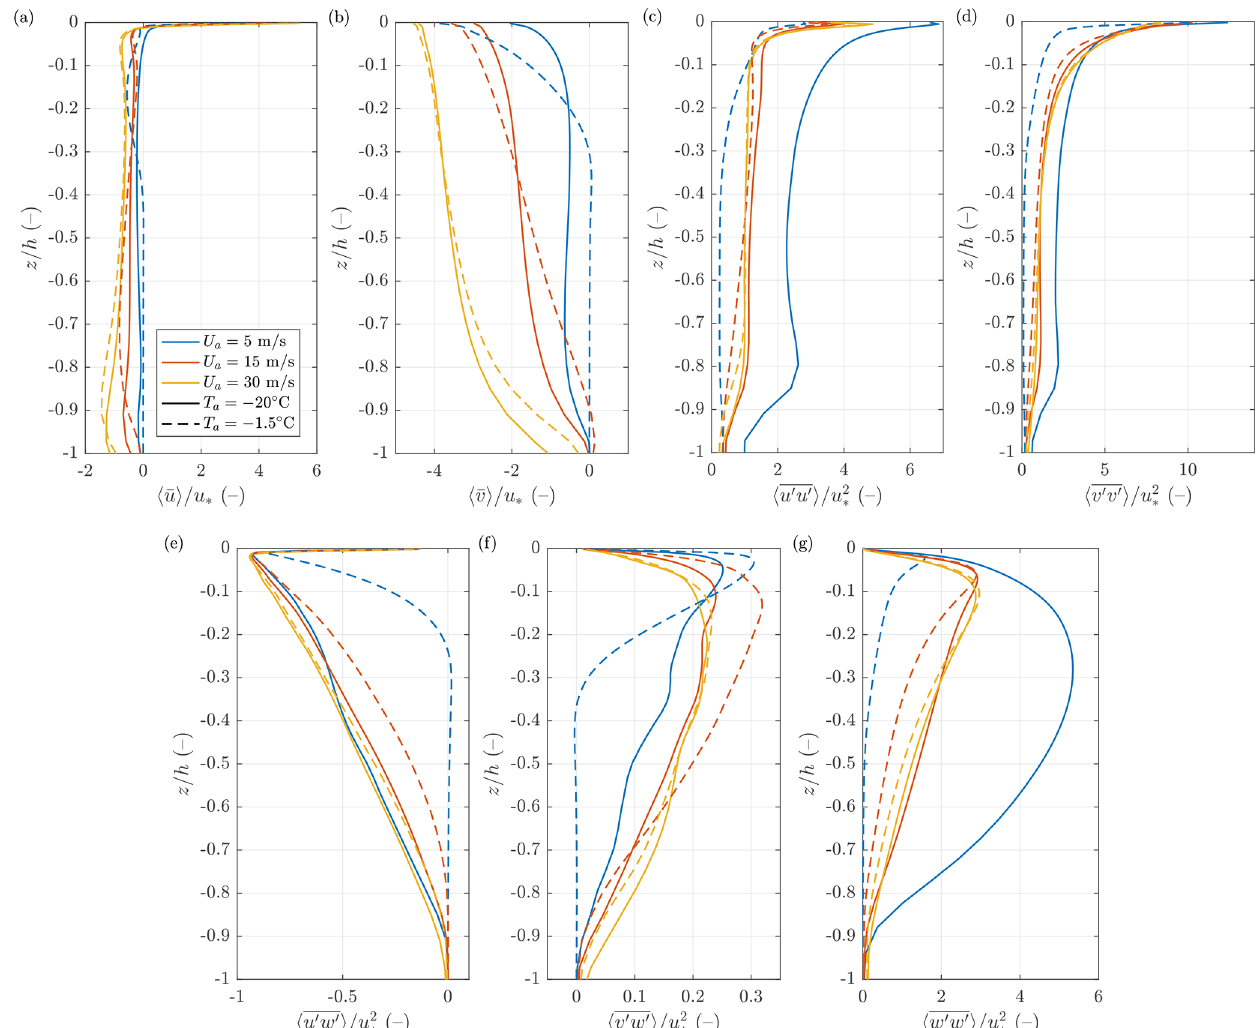
Figure 5. Vertical profiles of the mean velocity (a,b) , momentum flux (e, f) , and velocity variance (c, d, g) for different combinations of U a (colors) and T a (line styles). Results of simulations without frazil coupling (series F 0 ). All values are normalized with the respective friction velocity u ∗